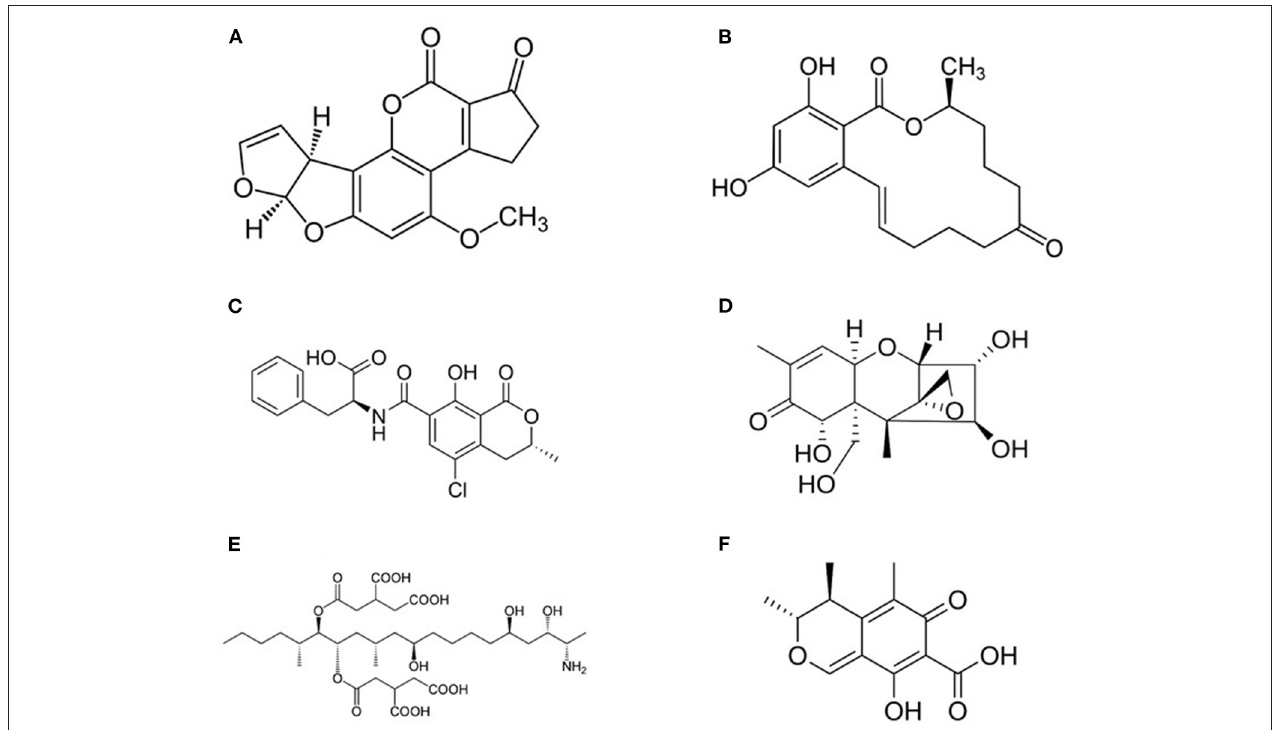
FIGURE 3 | Structure of most common mycotoxins in feed. (A) Aflatoxin B1 (2,3,6a,9a-tetrahydro-4-methoxycyclopenta(c)furo(3’,2’:4,5)furo(2,3-h)(1)benzo-pyran-1, 11-dione); (B) Zearalenone [(3S,11E)-14,16-Dihydroxy-3-methyl-3,4,5,6,9,10-hexahydro-1H-2-benzoxacyclotetradecine-1,7(8H)-dione]; (C) Ochtatoxin A (N-[(3R)-5-Chloro-8-hydroxy-3-methyl-1-oxo-3,4-dihydro-1H-2-benzopyran-7-carbonyl]-L-phenylalanine); (D) Nivalenol [(3 α ,4 β ,7 α )-12,13-epoxy-3,4,7,15- tetrahydroxy-trichothec-9-en-8-one] is a mycotoxin of the trichothecene group; (E) Fumonisin B1 [p(2S,2 ′ S)-2,2 ′ -[(5S,6R,7R,9R,11S,16R,18S,19S)-19-Amino-11,16, 18-trihydroxy-5,9-dimethylicosane-6,7-diyl]bis[oxy(2-oxoethane-2,1-diyl)]dibutanedioic acid]; (F) Citrinin (3R,4S)-8-Hydroxy-3,4,5-trimethyl-6-oxo-4, 6-dihydro-3H-2-benzopyran-7-carboxylic